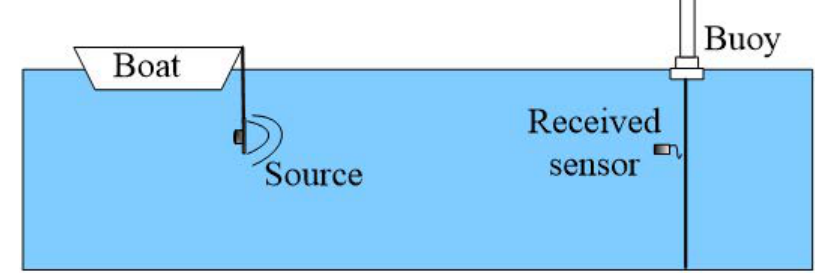
Figure 9. The sound speed profile in water.